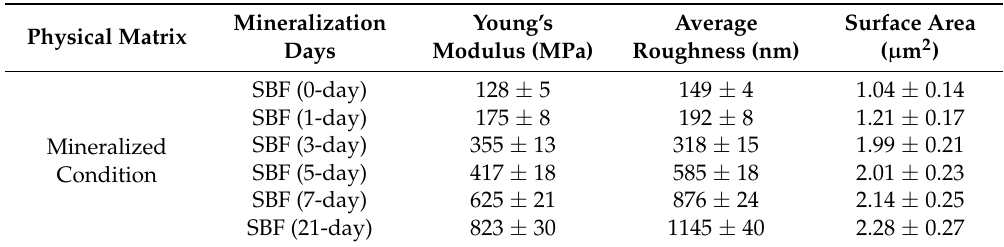
Table 1. Young’s Modulus, Average Roughness and Surface Area results of PLA nanofibers with different mineralization